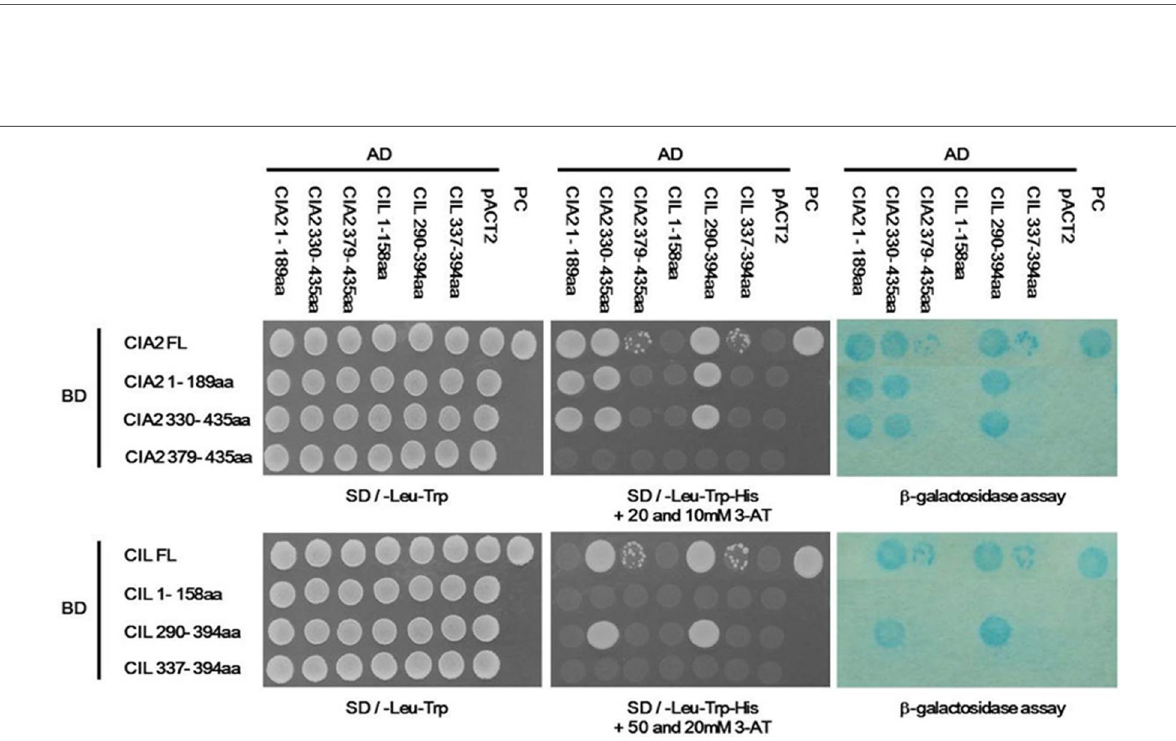
20 or 50 mM 3‑AT autotrophy, and β‑galactosidase +